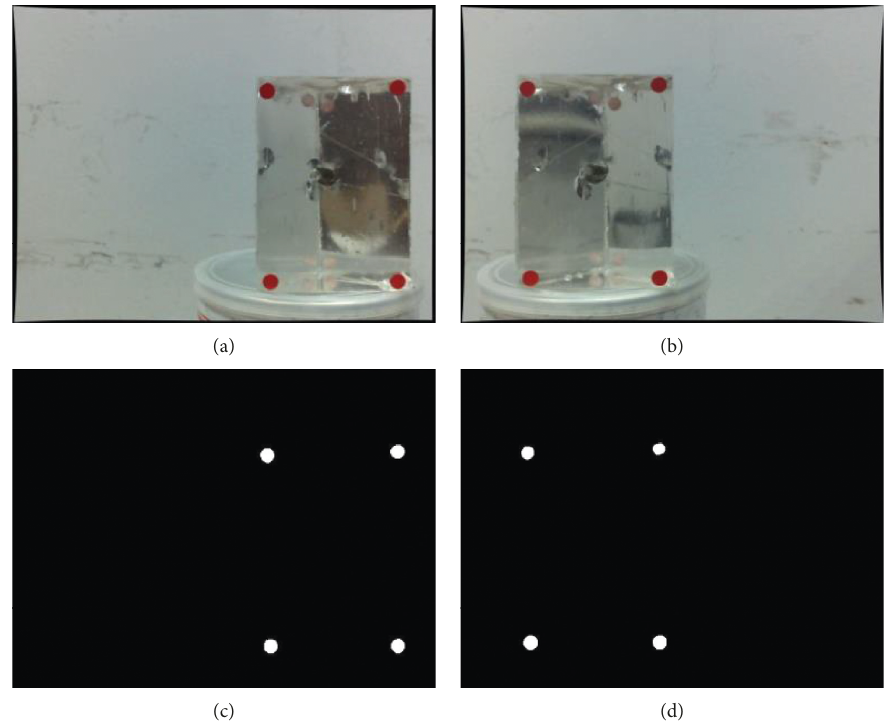
Figure 11: The measurement of the refractive plane parameters, where (a) and (b) are the binocular images and (c) and (d) are the corresponding extracted binary results of the red circles on the four corners of the sample surface.